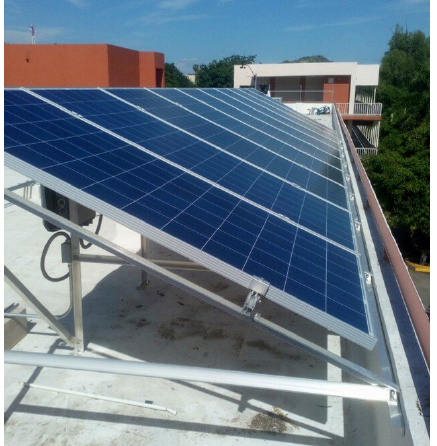
Figure 5. Physical system for the Hermosillo site